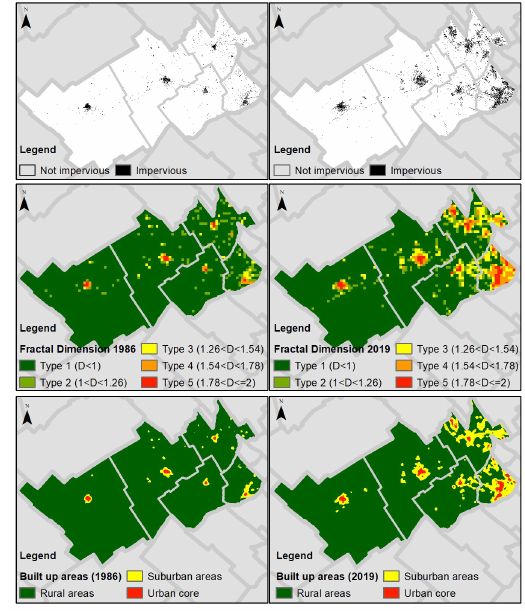
Figure 3. Spatio temporal types of built-up areas in